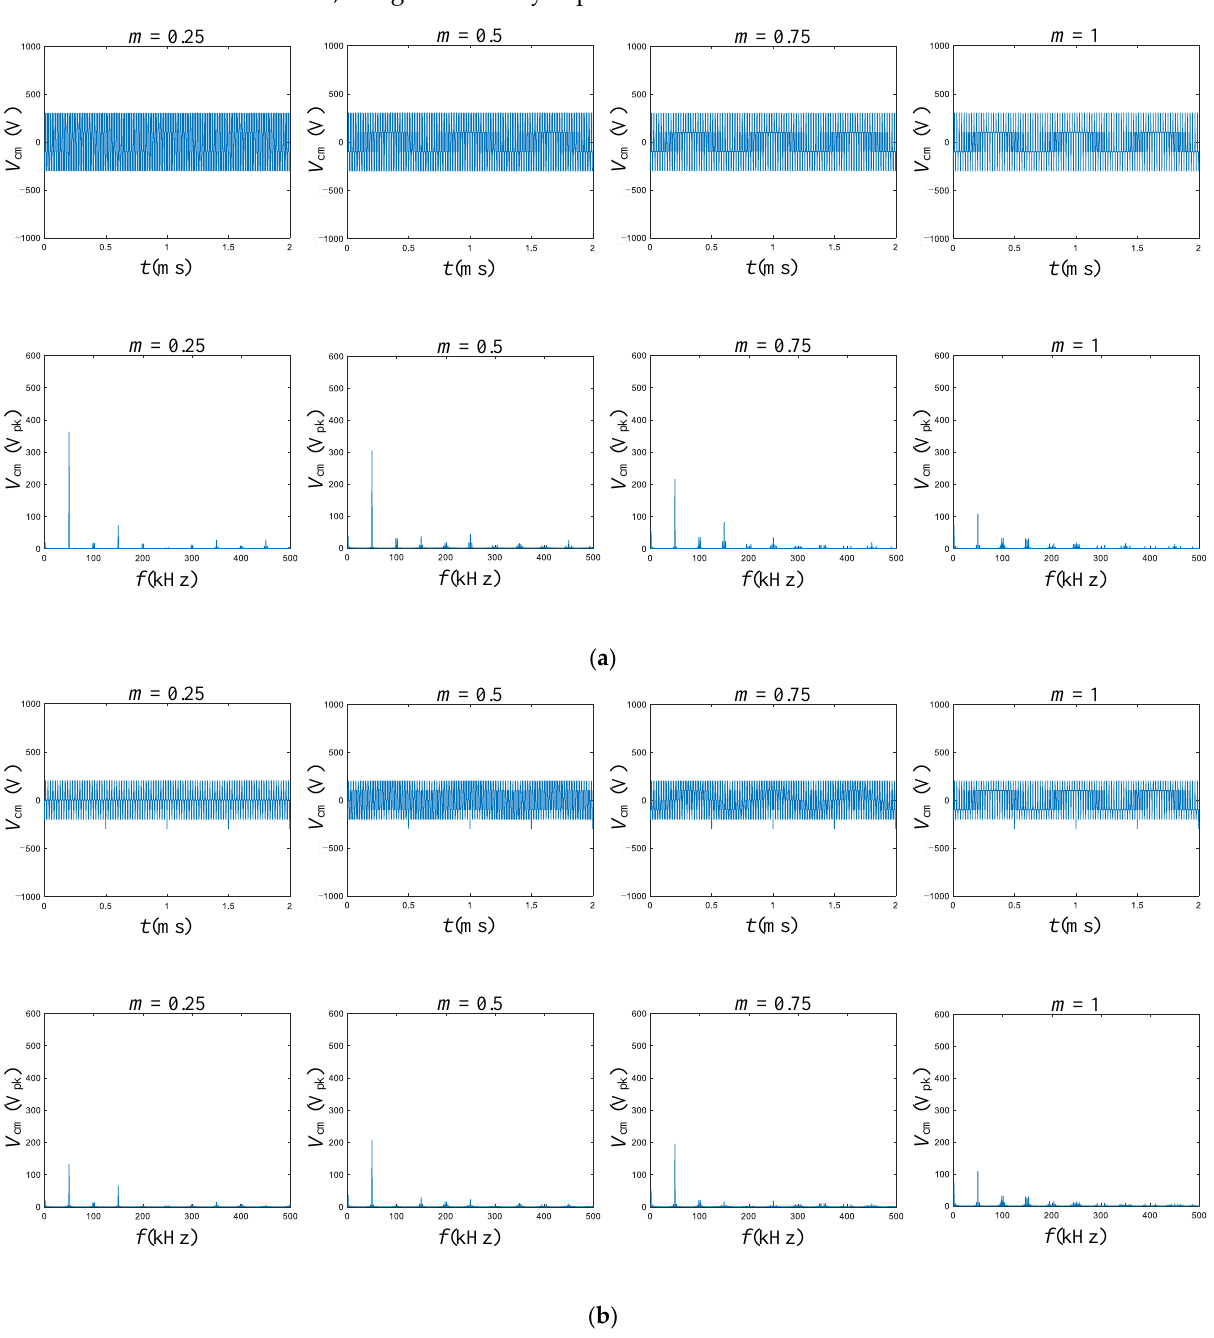
Figure 11. Time-domain and frequency-domain plots of the common-mode voltage in EV 2 under different modulation index values. ( a ) Design A. ( b ) Design B.